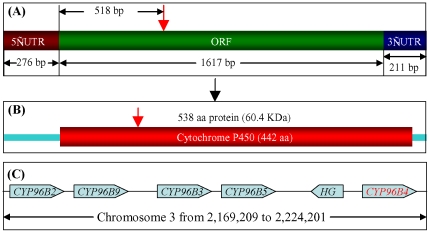
The genomic organization, structure and sequence analysis of OsCYP96B4 and its protein.(A) Full-length cDNA of the OsCYP96B4 gene showing various regions and the Ds insertion position as indicated by the red arrow. (B) The OsCYP96B4 protein showing the P450 domain (from Pfam database search; http://www.sanger.ac.uk/Software/Pfam/search.shtml) and the corresponding position of Ds insertion as indicated by the red arrow. (C) The tandemly duplicated 5 genes encoding the same class of P450 and their genome organization. The chromosome position of these genes were based on the release 6.1 of the Rice Pseudomolecules published by the Rice Genome Annotation Project (http://rice.plantbiology.msu.edu/index.shtml). HG, hypothetical protein.